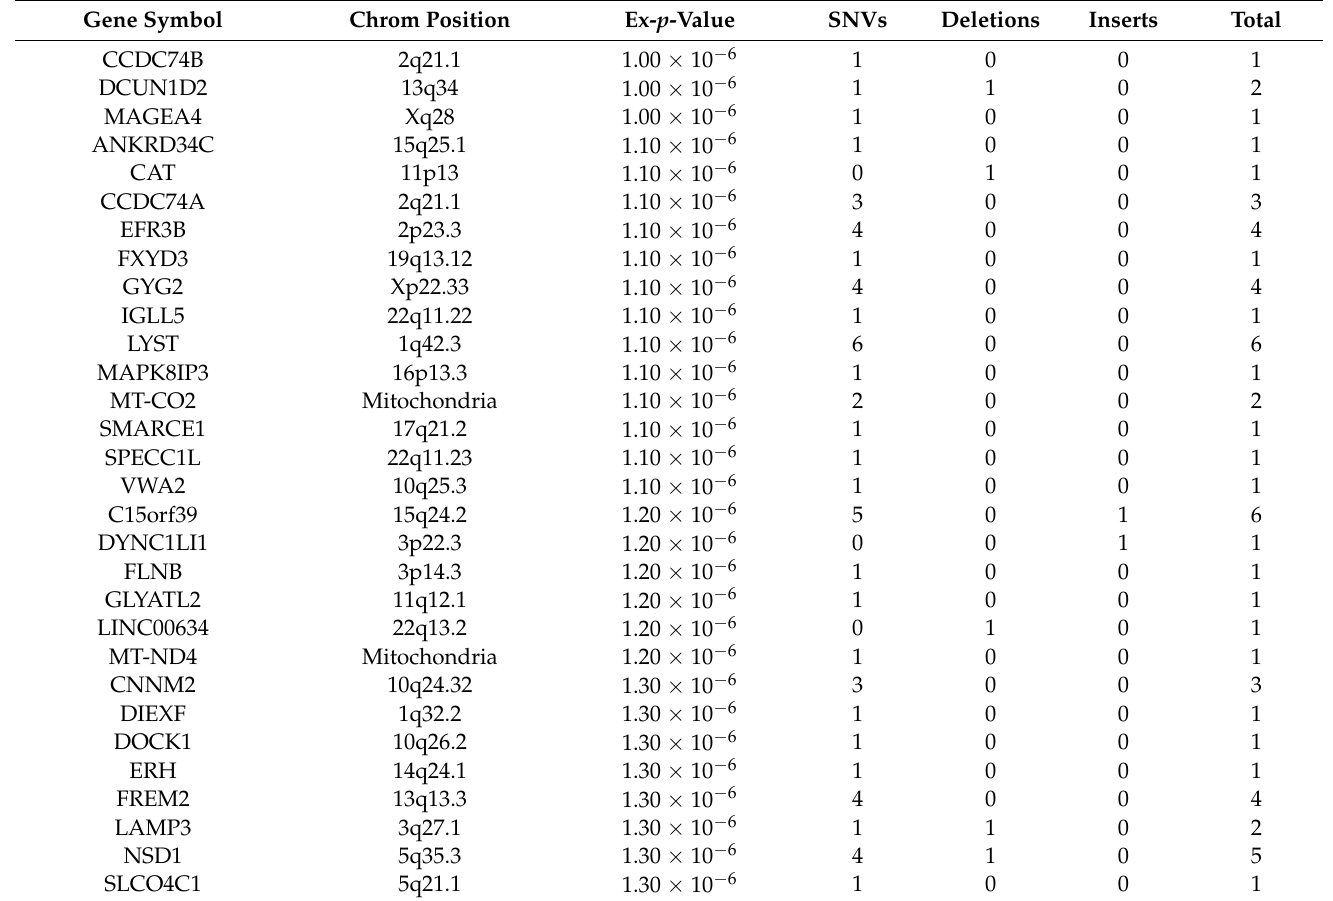
Table 1. List of the top 30 somatic mutated genes highly significantly associated with